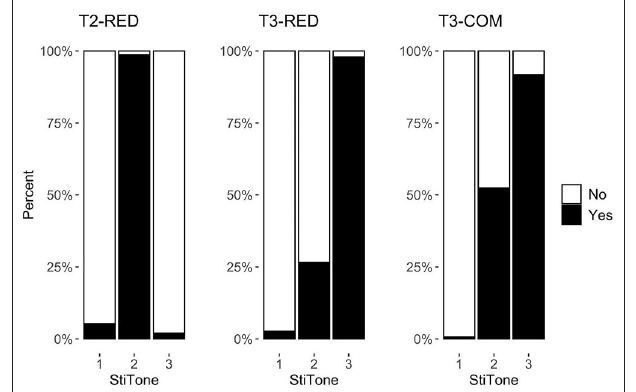
FIGURE 2 | Response types across three target constructions (StiTone refers to the tone of the auditory stimulus item).